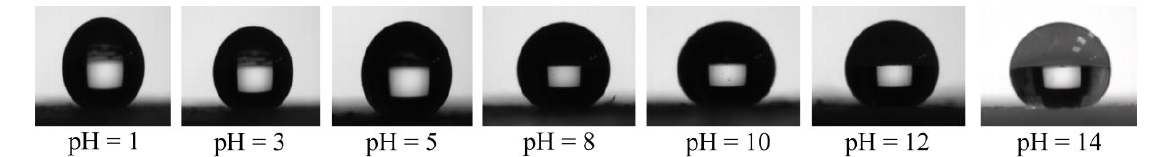
Figure 10. Shape of different pH solution droplets on FEP-S coating.